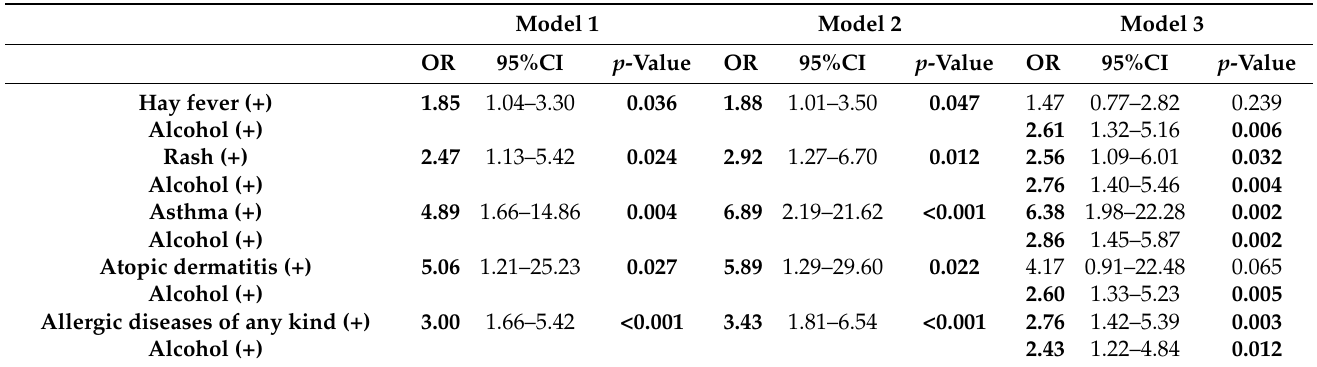
Table 2. Association between the presence of various allergic diseases and a high IgE level ( ≥ 173 IU/mL).